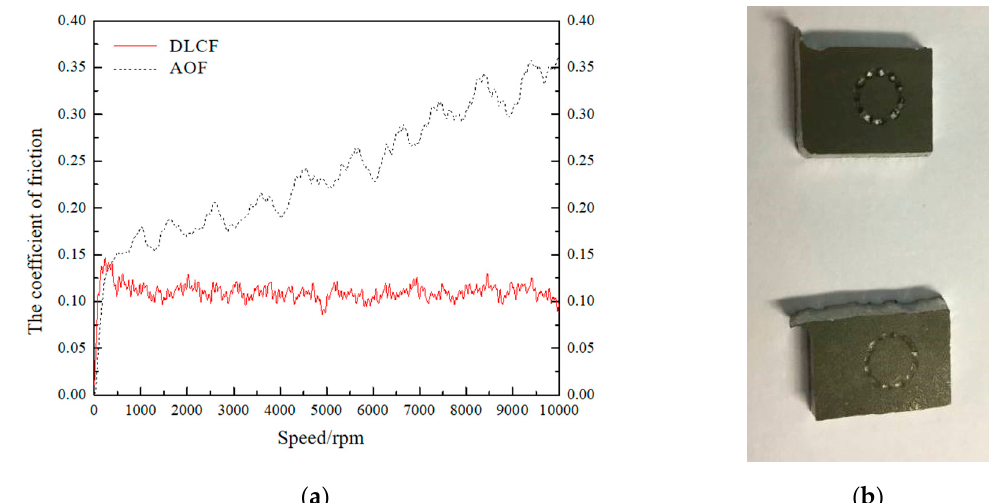
Figure 7. The friction coefficient curve and the test samples: ( a ) the friction coefficient curve; ( b ) the test samples.